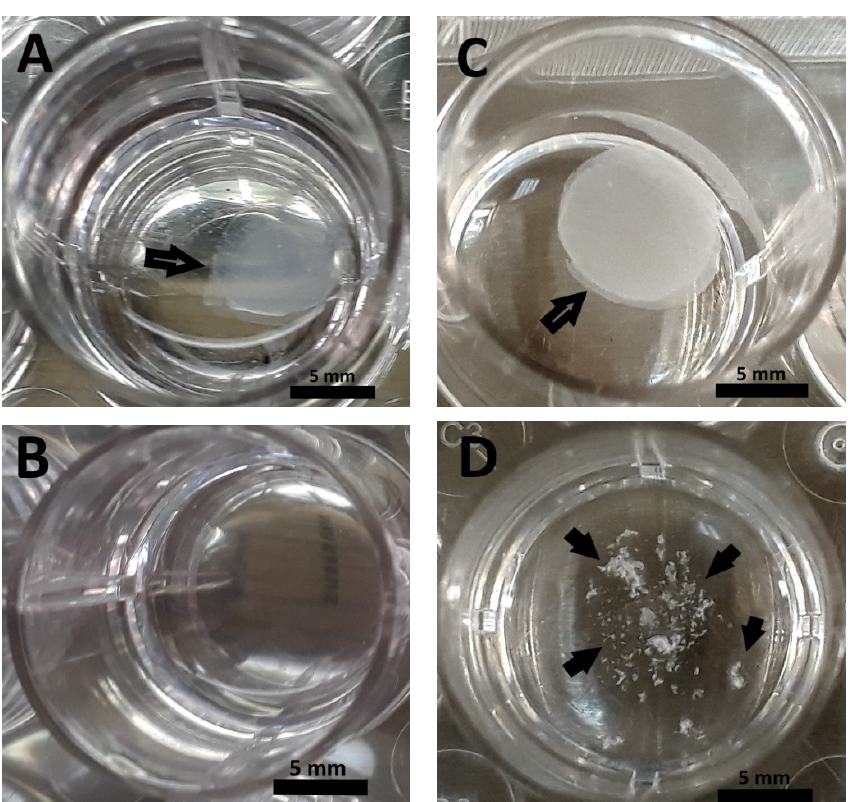
Figure 7. Appearance of scaffold samples after 1008 h of biodegradation in vitro: ( A )—series A, ( B )—series B, ( C )—series C , ( D )—series D. Arrows indicate scaffolds and their fragments.